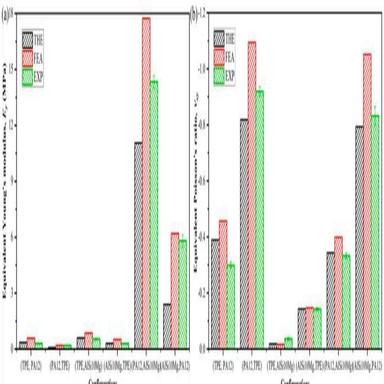
Theoretical, numerical and experimental results of (a) equivalent Young's modulus Ey and (b) Poisson's ratio νxy of the six kinds of bimaterial 3D DVH lattices.